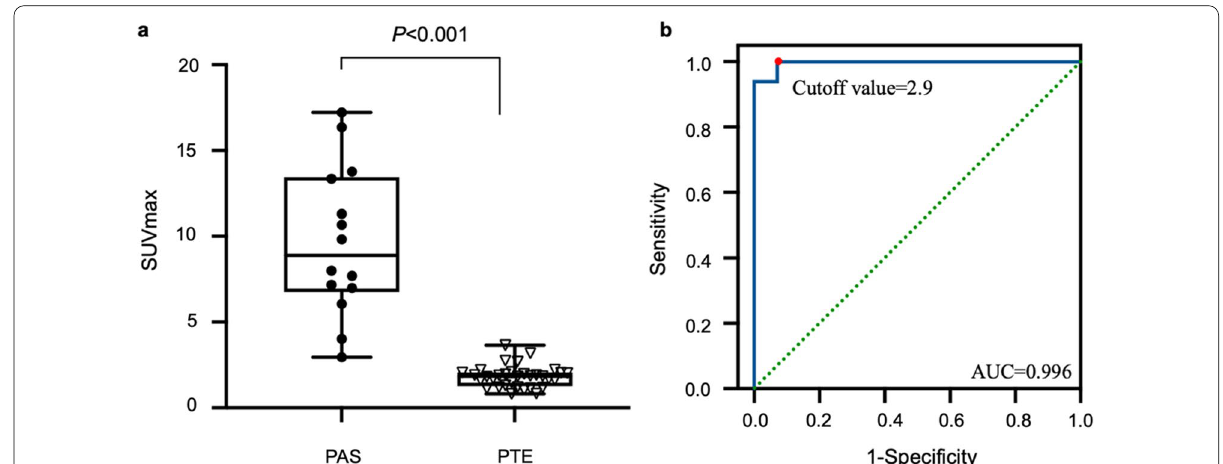
Fig. 5 (a) The difference in SUVmax between PAS and PTE groups ( P < 0.001). (b) Using ROC to identify the best cutoff value of SUVmax for distinguishing PAS from PTE